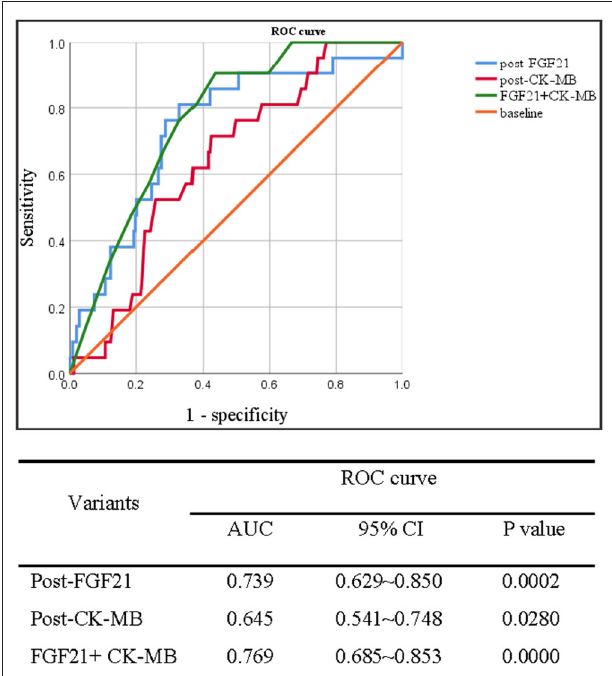
FIGURE 2 | Receiver operating characteristic curve analysis of serum FGF21 levels in between pre- and post-CABG for predicting the MACE of 265 patients with MI after 48h of CABG surgery. Upper panel: ROC curve; down panel: the area under ROC (AUC) curve.